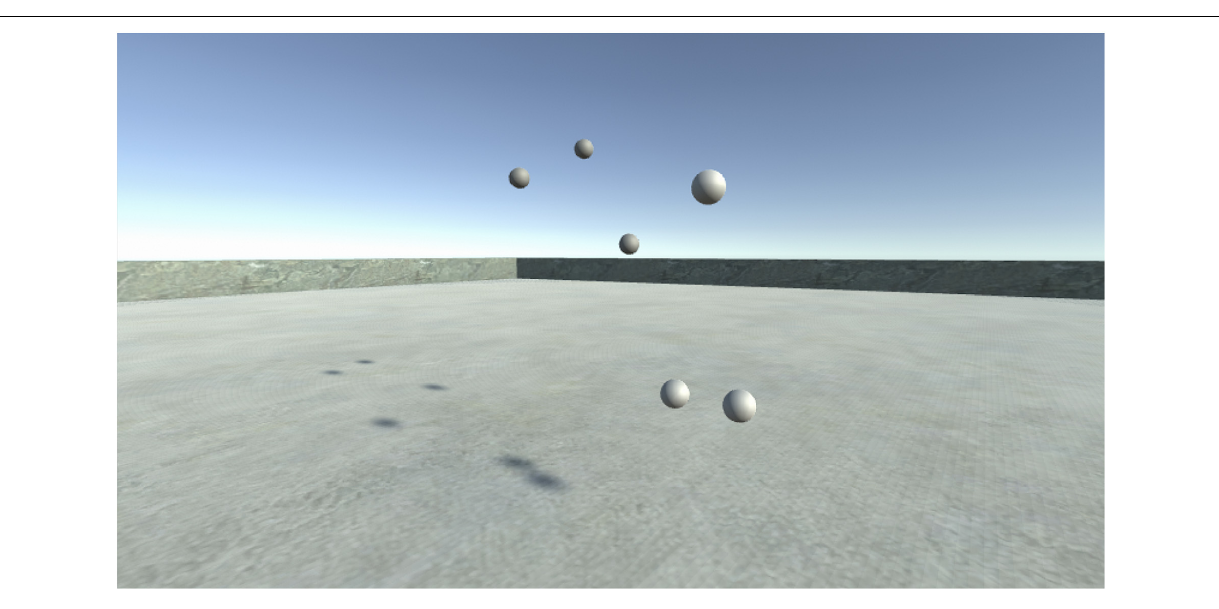
FIGURE 2 | Visualization of the virtual scenery from a third person point of view. We can see the two participants each symbolized as three spheres in the virtual